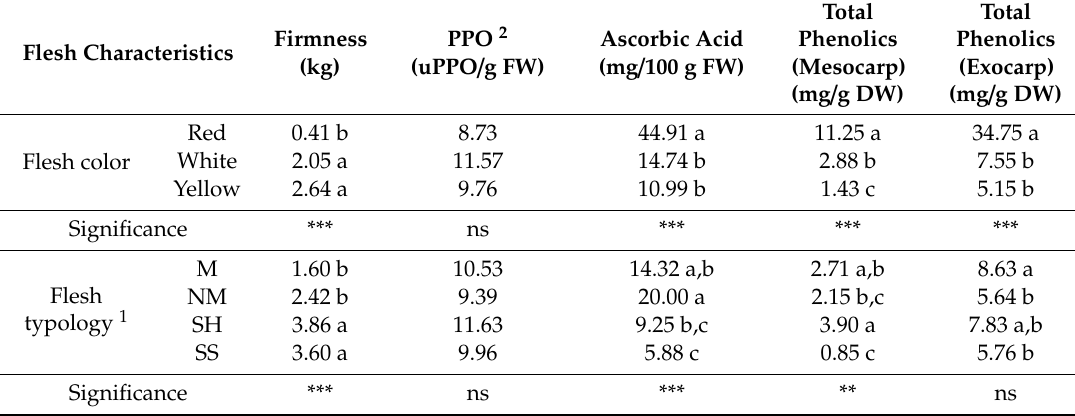
Table 2. The e ff ect of flesh characteristics (color and textural typology) across 14 cultivars on quality and biochemical attributes, such as firmness, PPO, ascorbic acid and total phenolic concentration in the mesocarp and